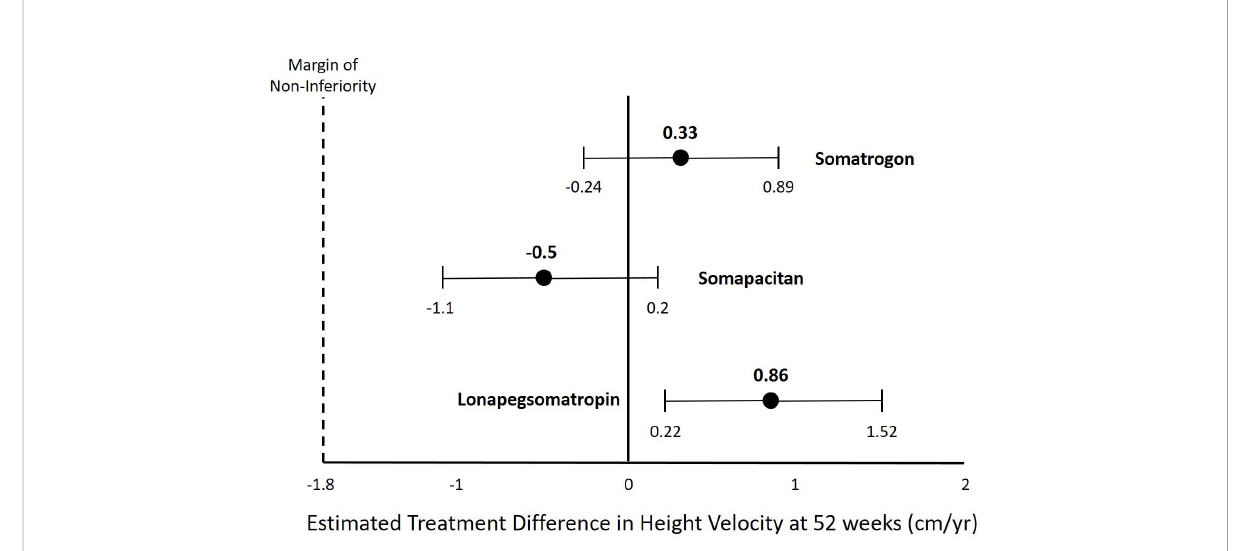
FIGURE 1 Estimated Treatment Difference in Height Velocity for Different Long-Acting Growth Hormone Products.